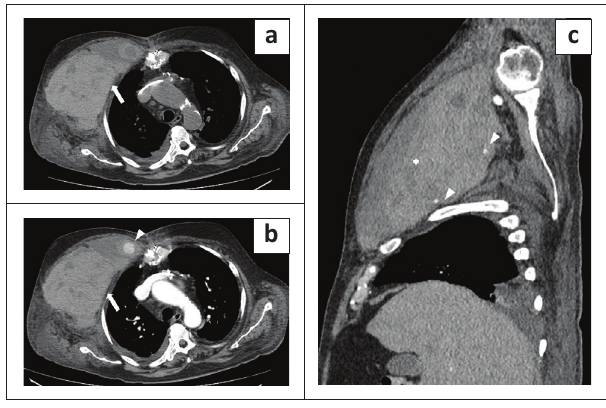
FIGURE 5: A 79-year-old man with a chest haematoma diagnosed 10 days after hospital admission. (a) Axial plane, not-enhanced phase demonstrates a huge inhomogeneous haematoma in the right chest wall (arrow). (b) Axial arterial phase image shows an active arterial bleed (arrowhead) in the medial part of the haematoma (arrow). (c) Parasagittal plane, arterial phase indicates the ellipsoid shape of the haematoma (asterisk). Some other small contrast blushes can be seen in the posterior part of the haematoma (arrowheads). The patient underwent endovascular embolisation and survived.